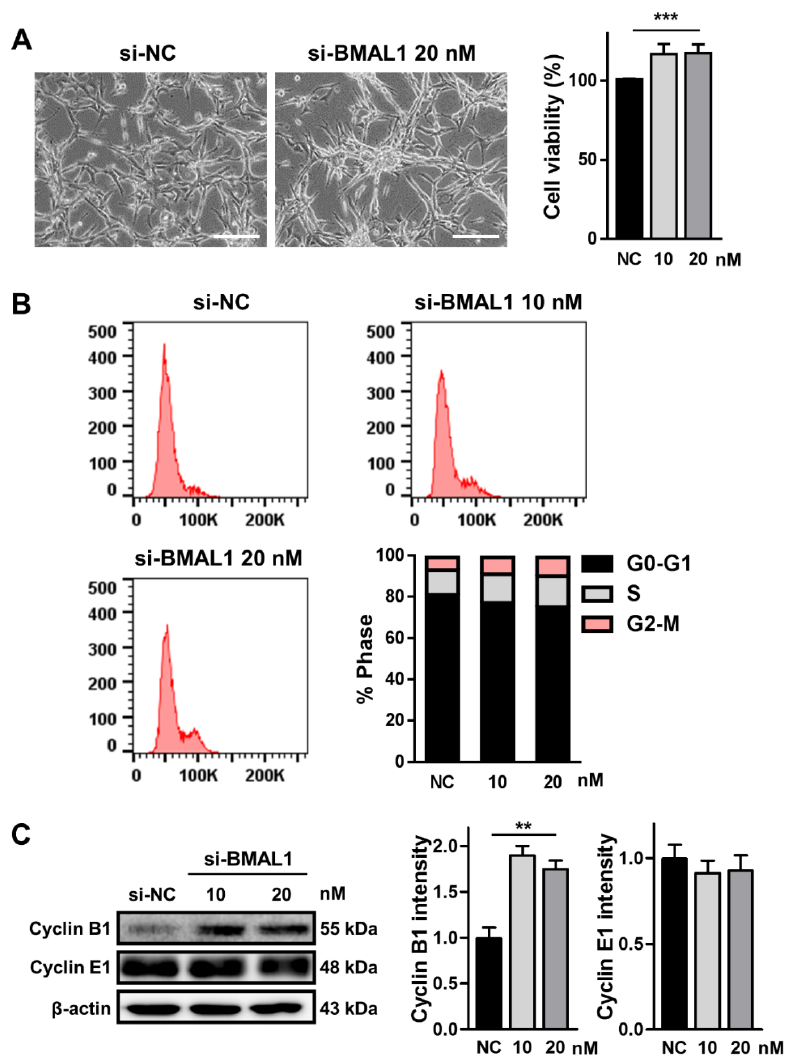
Figure 2. Knockdown of BMAL1 in U87MG cells by BMAL1 siRNA increased cell proliferation via upregulation of cyclin B1. ( A ) U87MG cells were incubated with si-NC (10 nM) and si-BMAL1 2-yl)-2,5-diphenyltetrazolium bromide (MTT) assay at 48 h post-transfection. Data are expressed as the mean ± SEM (one-way ANOVA test, *** p < 0.001 vs. NC, three independent experiments). ( B ) The flow cytometry from three independent experiments. ( C )The expression levels of cyclin B1 and